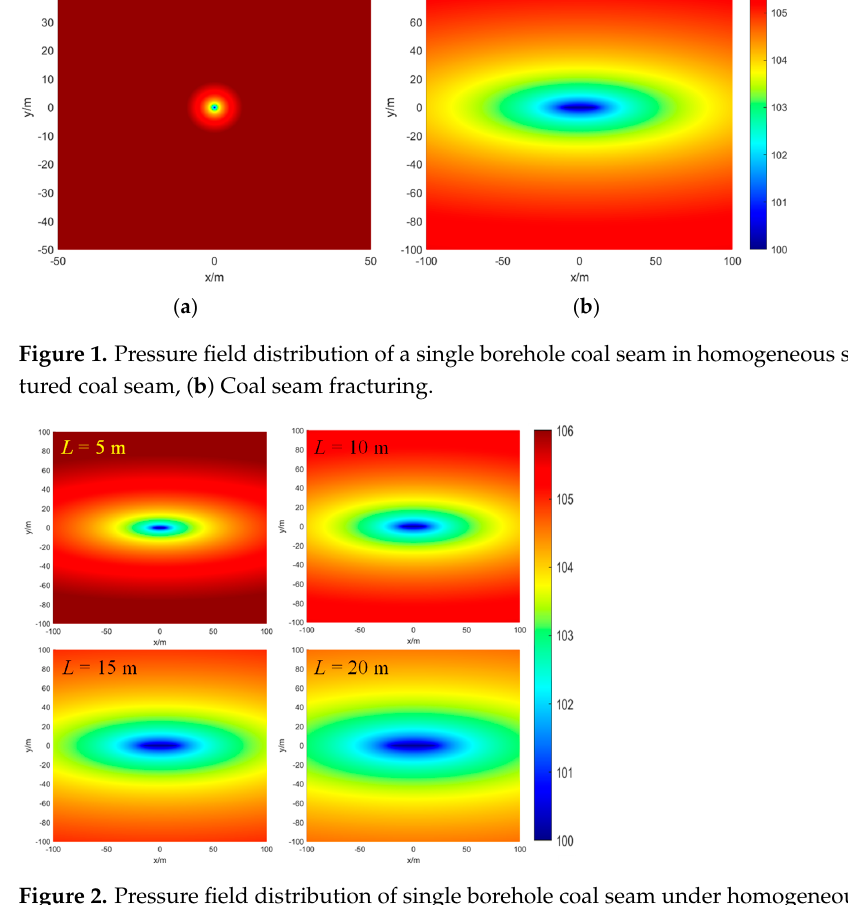
Figure 2. Pressure field distribution of single borehole coal seam under homogeneous fracturing.